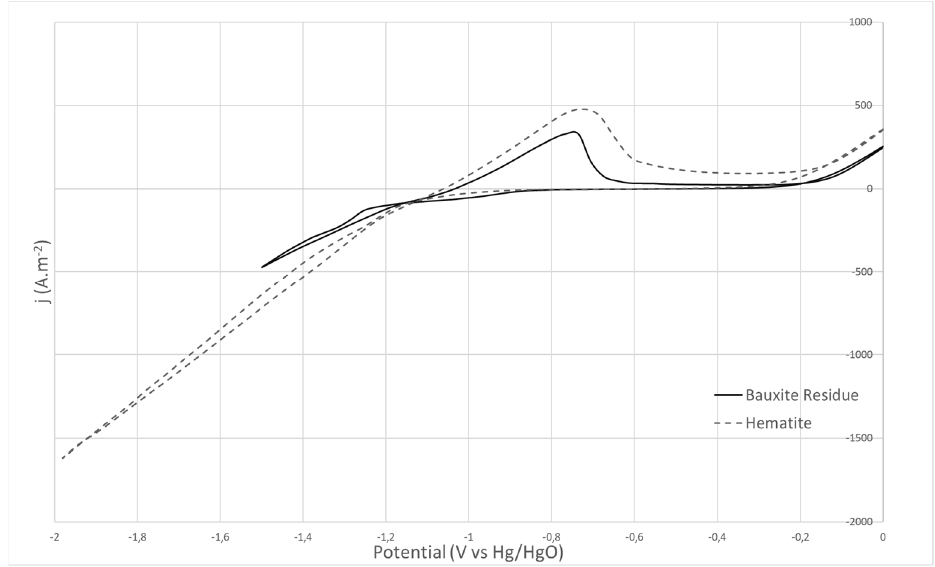
Figure 2. Cyclic voltammetry of BR and hematite with scanning rate of 100 mV/s.